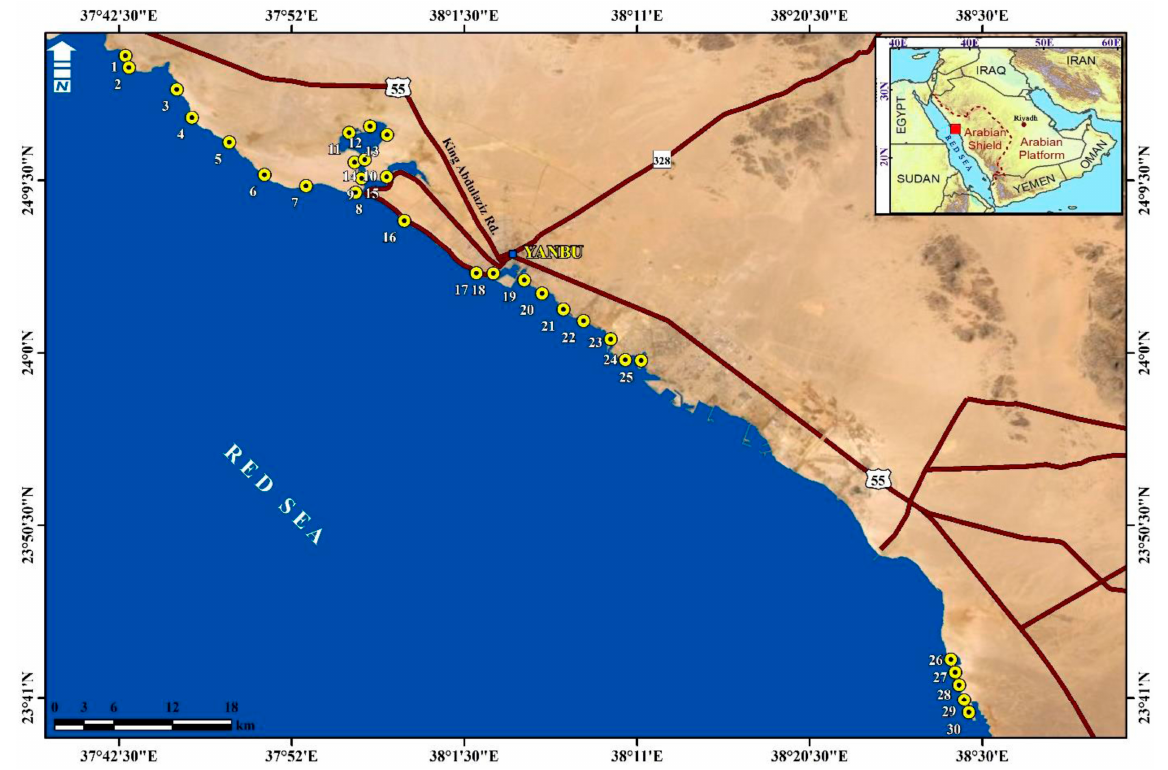
Figure 1. Study area map showing seawater sampling locations.